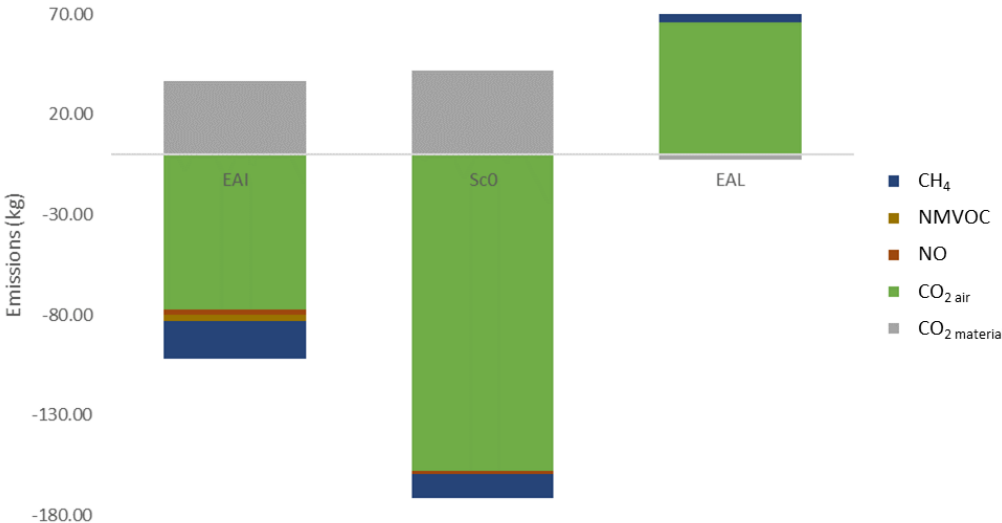
Figure 4. Global warming potential comparison for the reference case (Sc0) among average European scenarios. Results refer to one tonne of treated residues.